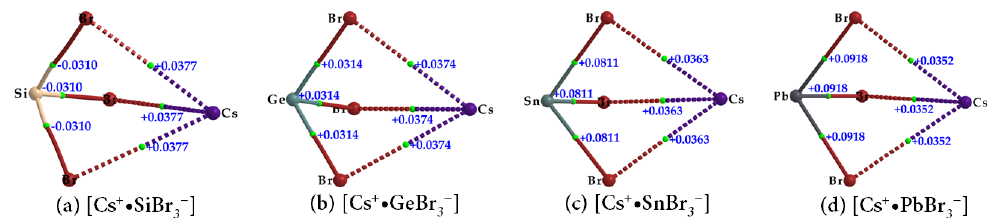
Figure 7. ( a – d ) QTAIM-based molecular graphs of tetrel bromide perovskite ion-pairs, [Cs + •TtBr 3 − ] (Tt = Si, Ge, Sn, and Pb), obtained with [ ω B97XD/def2-TZVPPD]. Values represent the Laplacian of the charge density ( ∇ 2 ρ b /au) at the Tt–Br and Cs···Br bond critical points. Atoms, bond paths, and bond critical points are shown as large spheres, solid/dotted lines in atom color, and tiny spheres in green, respectively. Table 2. Selected QTAIM-based topological charge density properties at Tt–Br and Cs···Br bcps of